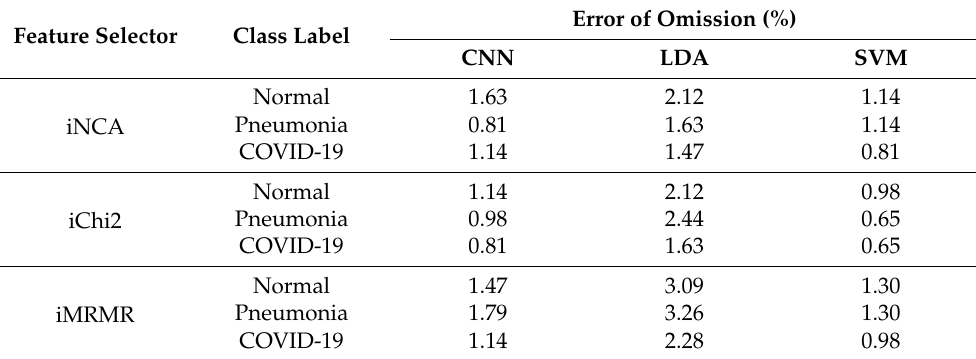
Table 8. Comparing the error of omission of the convolutional neural network (CNN), linear dis- criminant analysis (LDA), and support vector machine (SVM) for each class against the exploited feature-selection